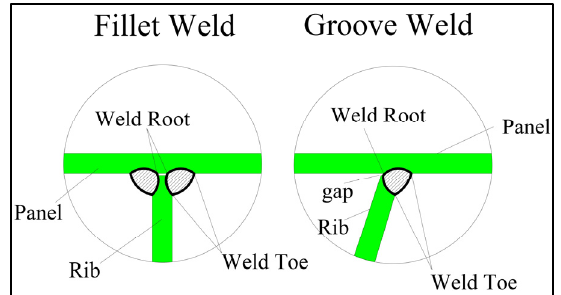
Figure 3. Panel and rib welded connection